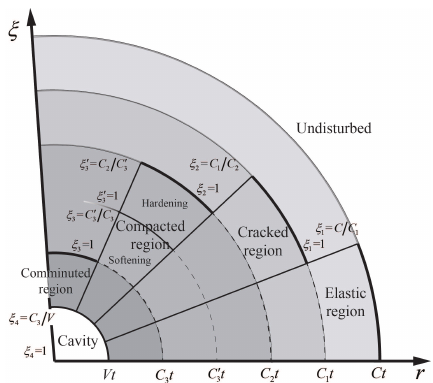
Figure 5. Diagram of compressible concrete media cavity expansion response regions. The interface speeds C , C 1 , C 2 , C (cid:48) , and C 3 and dimensionless variables S and ξ with different subscripts are used to 3 designates the boundaries of different response